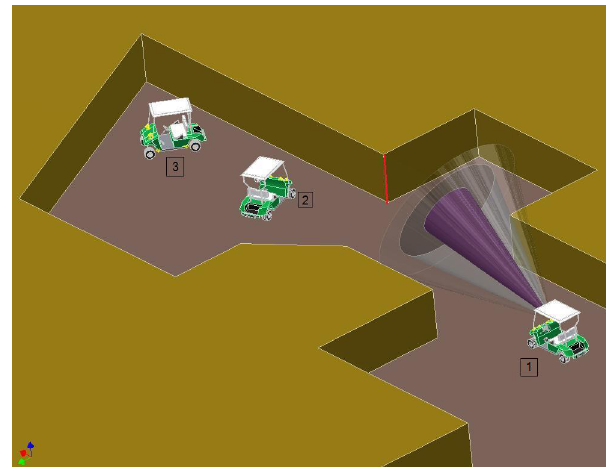
Figure 8. Image of the new scenario.